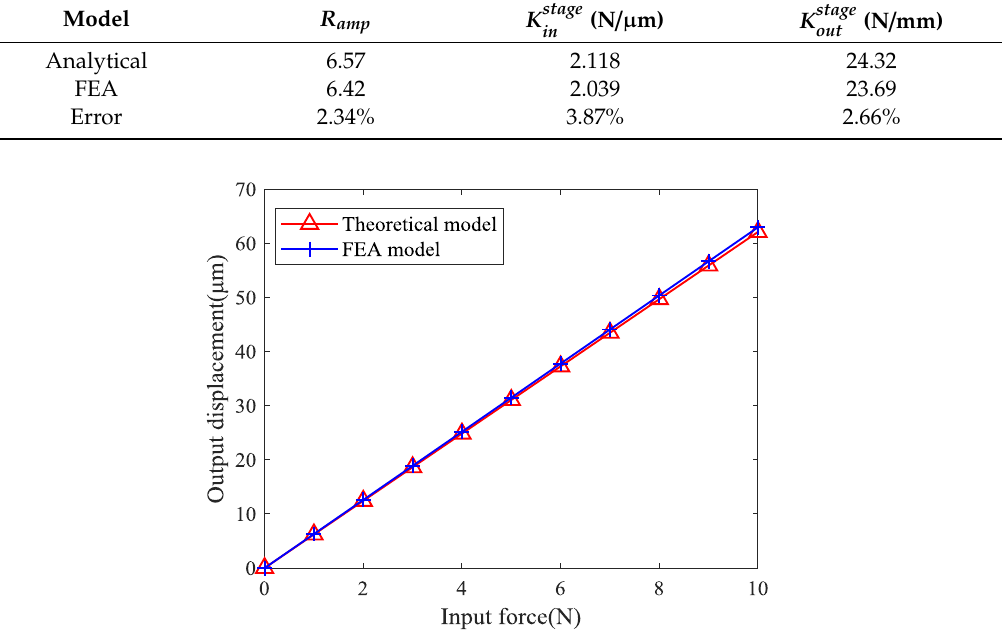
Figure 15. Input forces and output displacements of the stage.